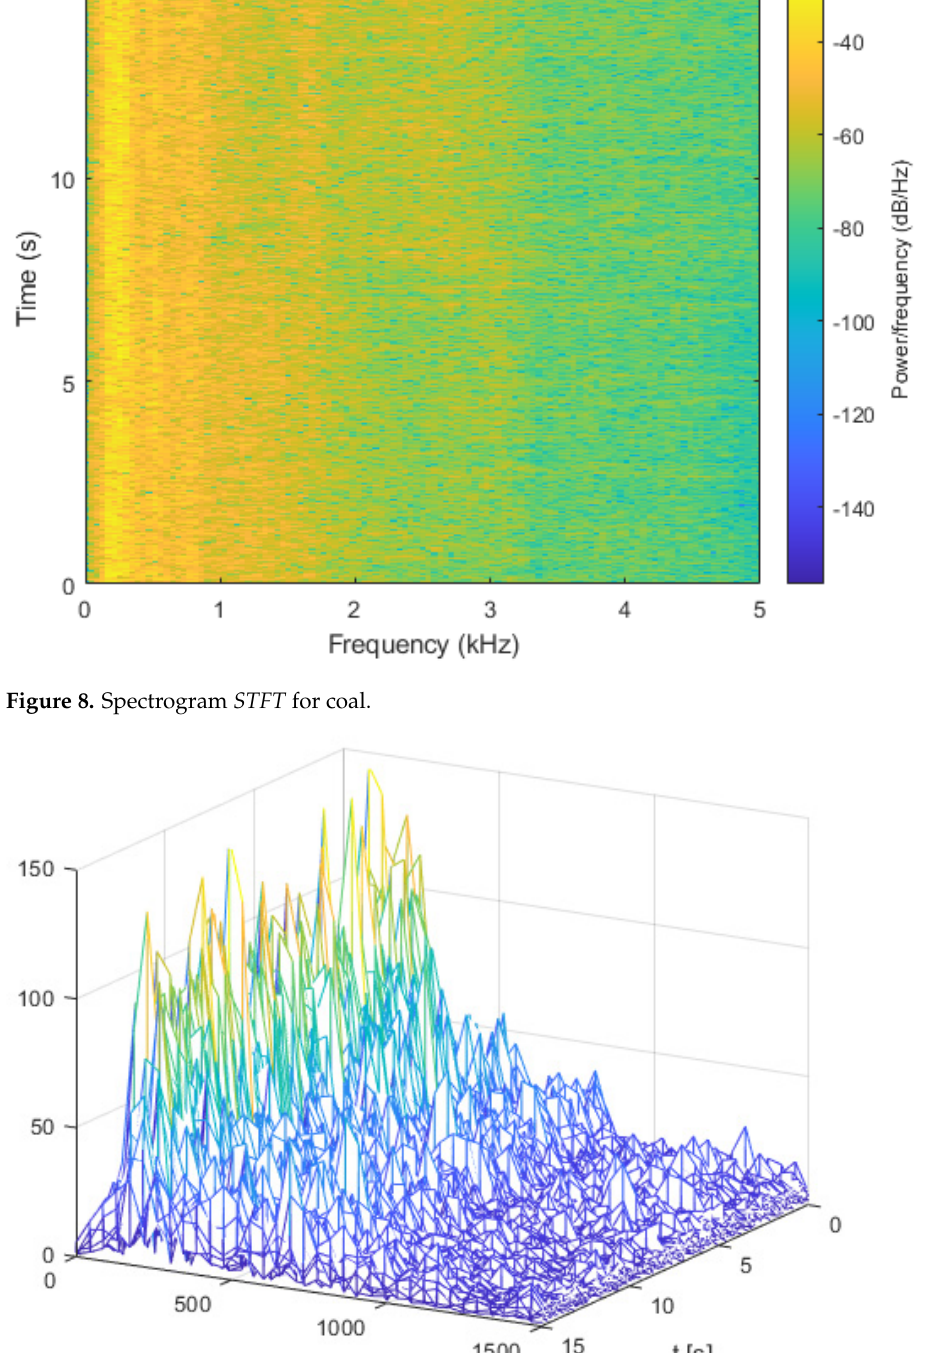
Figure 9. Three-dimensional graph STFT for coal.